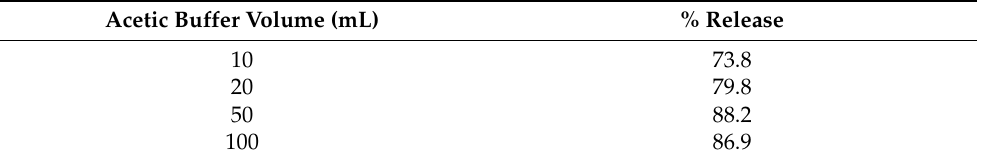
Table 1. Results on doxorubicin release in the equilibrium mode. Acetic Buffer Volume